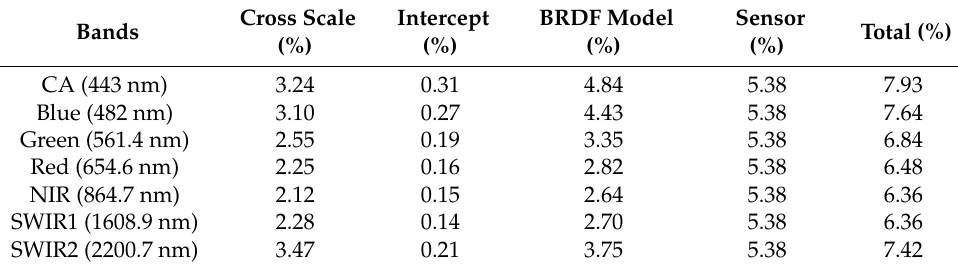
Table 10. Summary of all sources of